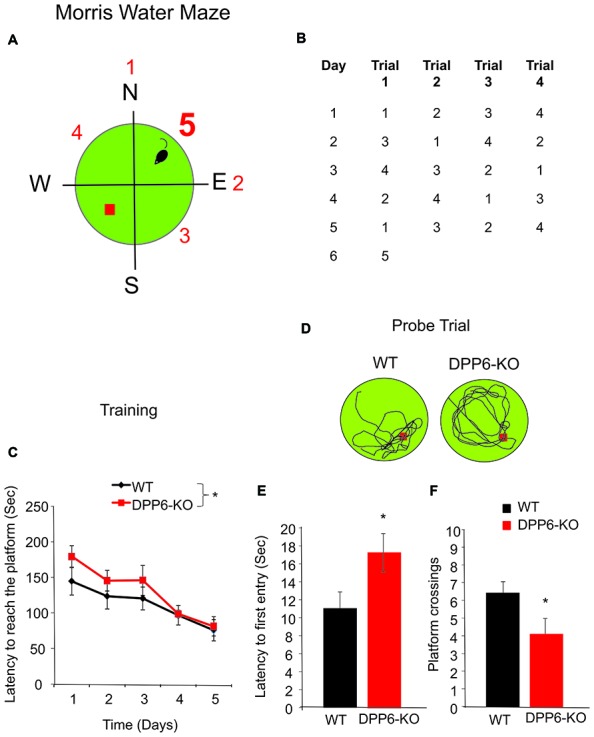
DPP6 mice show slower learning and memory impairments in the Morris water maze. (A,B) Schematic drawing showing the experimental design used to compare the performance of WT and DPP6 knockout (DPP6-KO) mice in the water maze. (C) Sum of latencies for four trials required to reach the platform in the water maze for WT (n = 10 mice) and DPP6-KO mice (n = 10 mice) over a training period of 5 days. (D) Representative swimming traces during the probe trial of the WT and DPP6-KO mice at day 6. (E,F) DPP6-KO mice are significantly slower to find the platform (E) and showed fewer platform crossings (F) compared to WT mice during the probe trail (*p < 0.05).